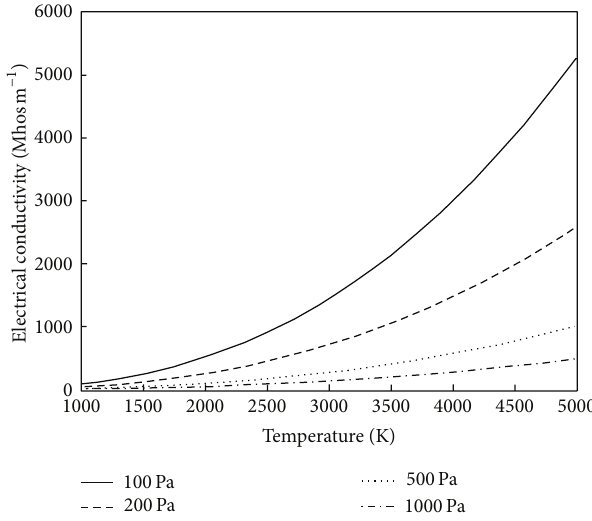
Figure 1: Electrical conductivity versus temperature for various